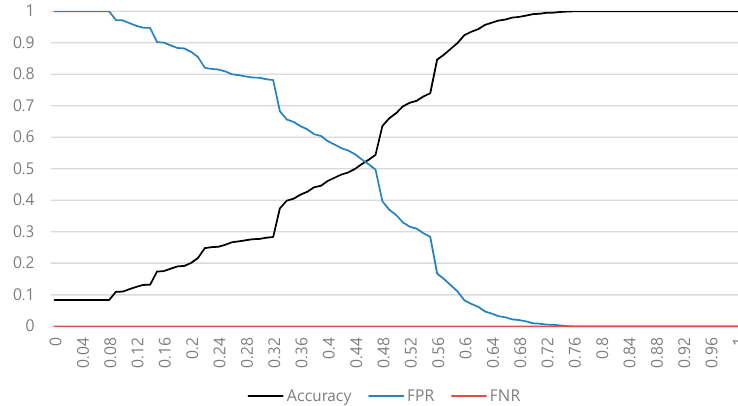
Figure 6. Classification result according to the obfuscation type 1 threshold in a lightweight AST.